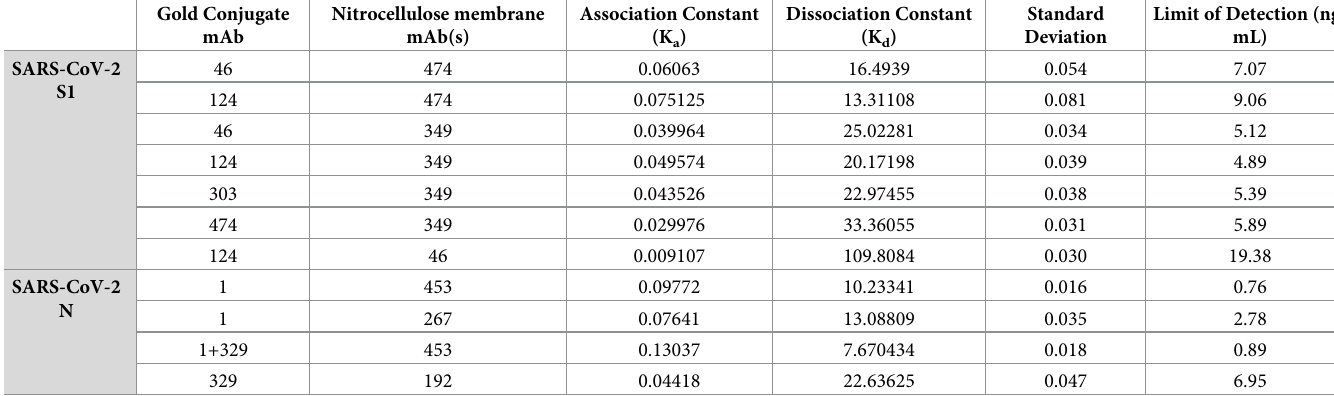
Table 2. Limit of detection of mAb combinations.